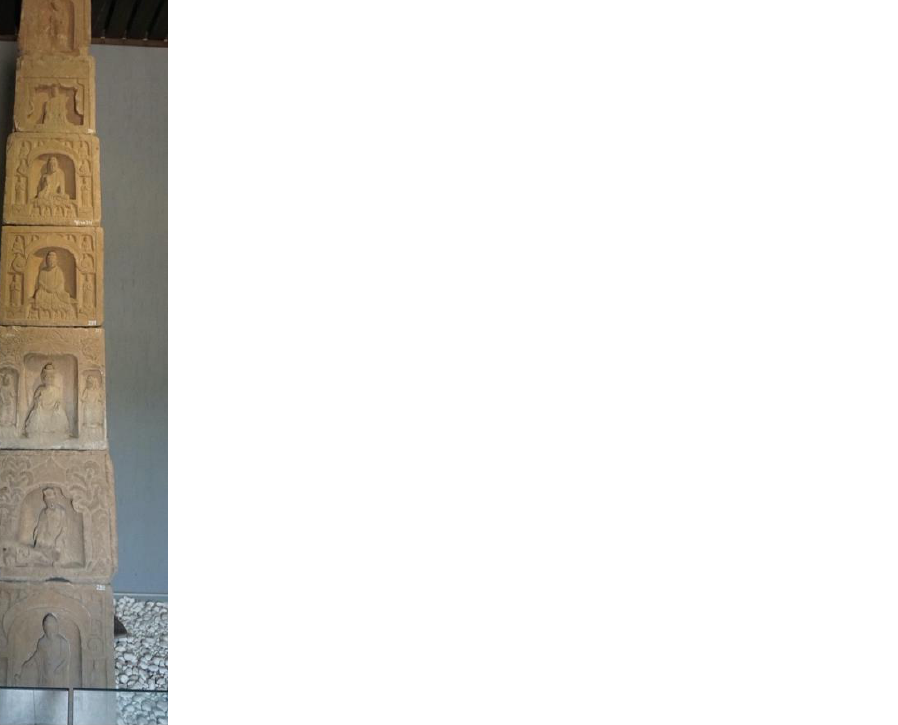
Figure 2. A Nannieshui pagoda in display. Early sixth century, Northern Wei. Stone. Nannieshui Museum. Photograph taken by the author.